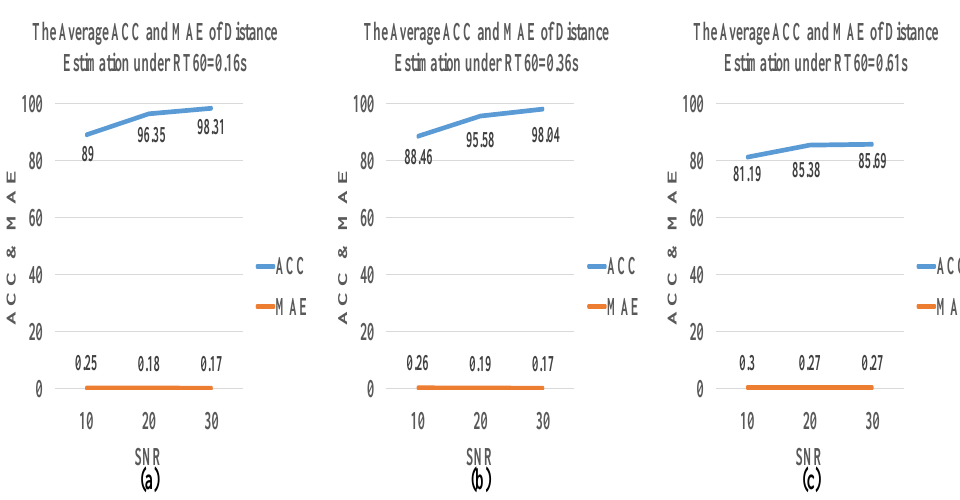
Figure 9. The average ACC and MAE of distance estimation by CNN-R in a multiple acoustic environment where SNR = 10 dB, 20 dB, and 30 dB, and ( a ) RT60 = 0.16 s, ( b ) RT60 = 0.36 s, and ( c ) RT60 = 0.61 s.